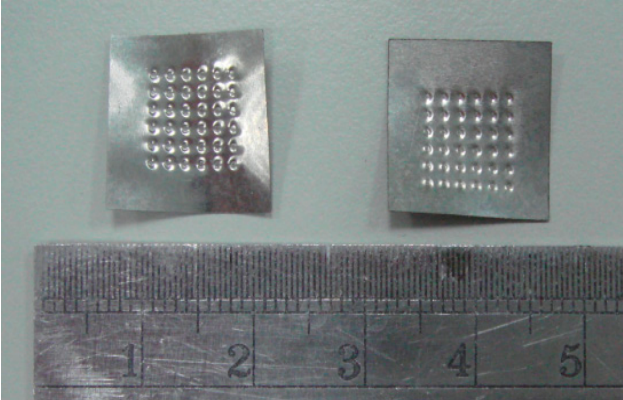
Figure 10. Processed workpiece of micro-channel array forming process.